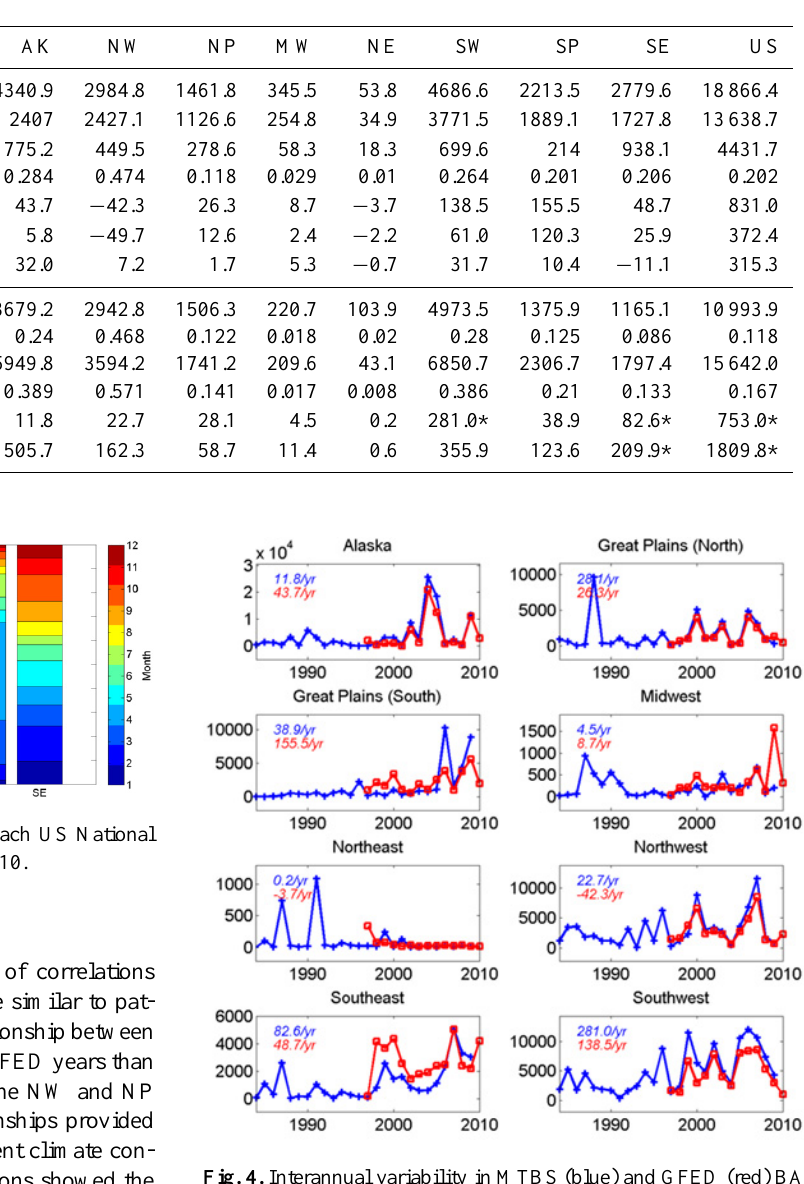
Table 2. Mean annual GFED (1997–2010) and MTBS (1984–2009) burned area (BA, km 2 yr − 1 ) for the US and sub-national NCA regions. significant BA trends based on robust linear regression ( p < 0.05).